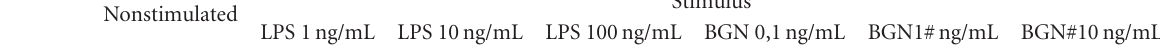
Table 2: Spontaneous and stimulated IL-6 production by peripheral blood mononuclear cells from patients with rheumatoid arthritis (RA), osteoarthrosis(OA), and healthy controls (HC); median values; P < . 05 ∗ —significantly di ff erent from nonstimulated; #—significant di ff erence between RA and HC ∧ —significant di ff erence between RA and OA.